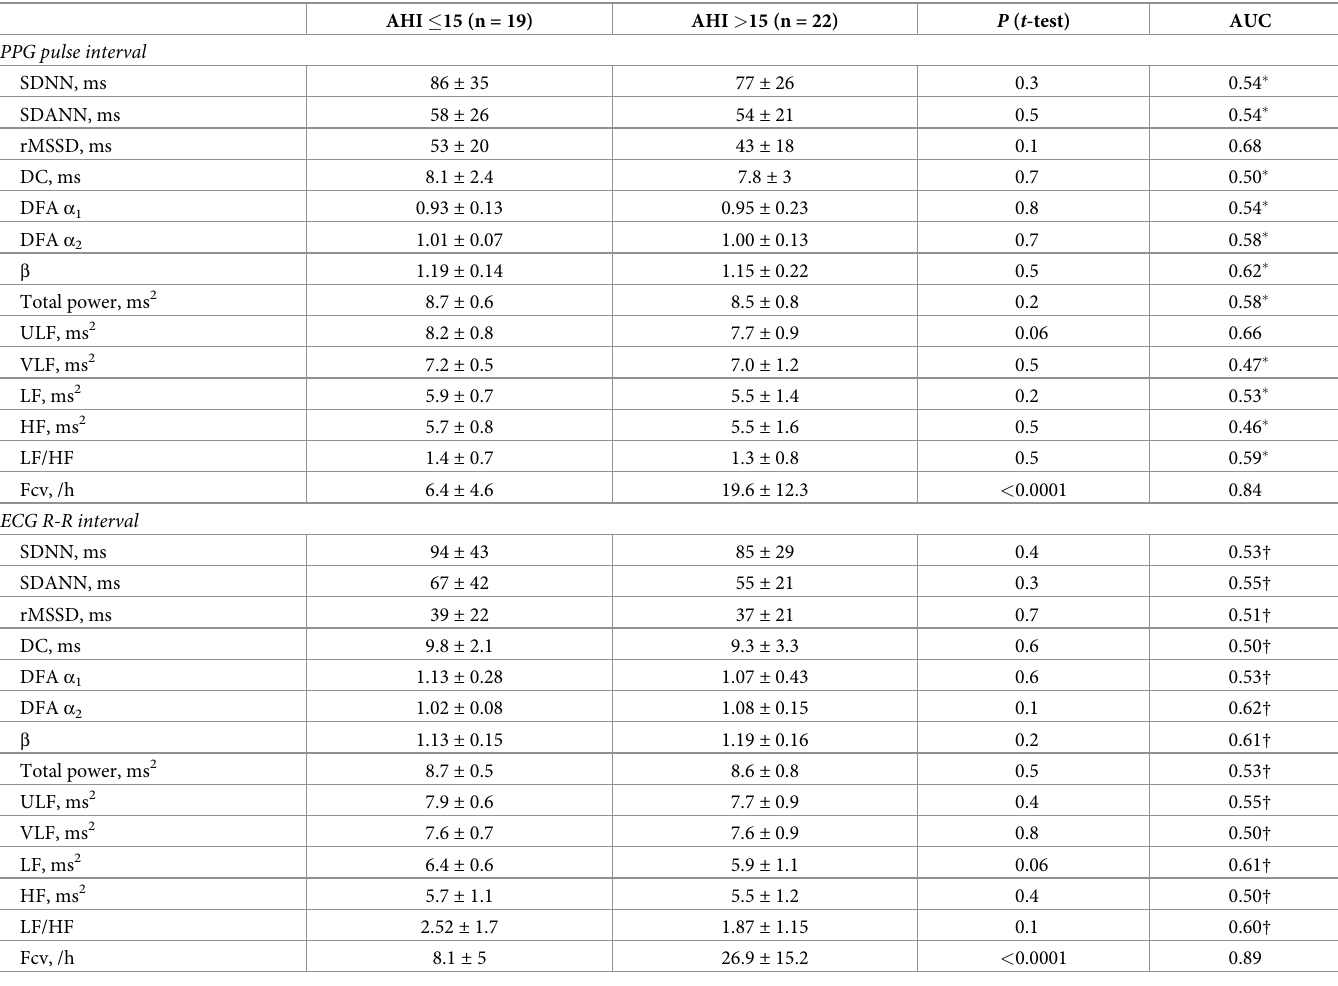
Table 4. PPG pulse interval and ECG R-R interval variability indices in patients grouped by AHI and the discriminant performance of the indices.